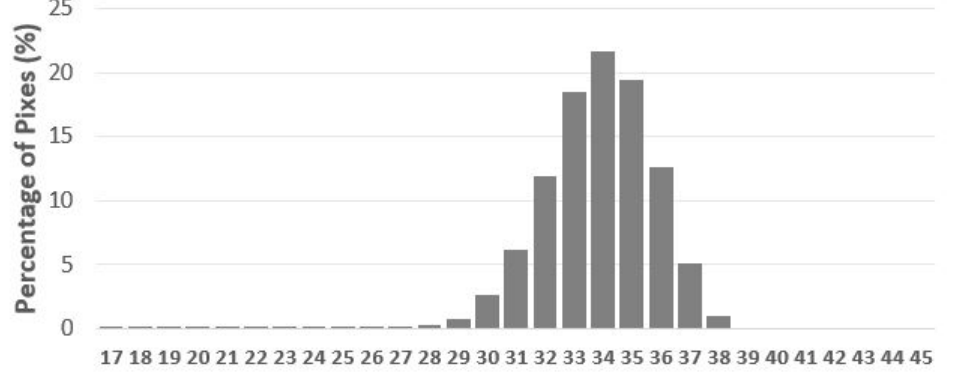
Figure 5. Cloud ‐ free pixel distribution. Figure 5. Cloud-free pixel